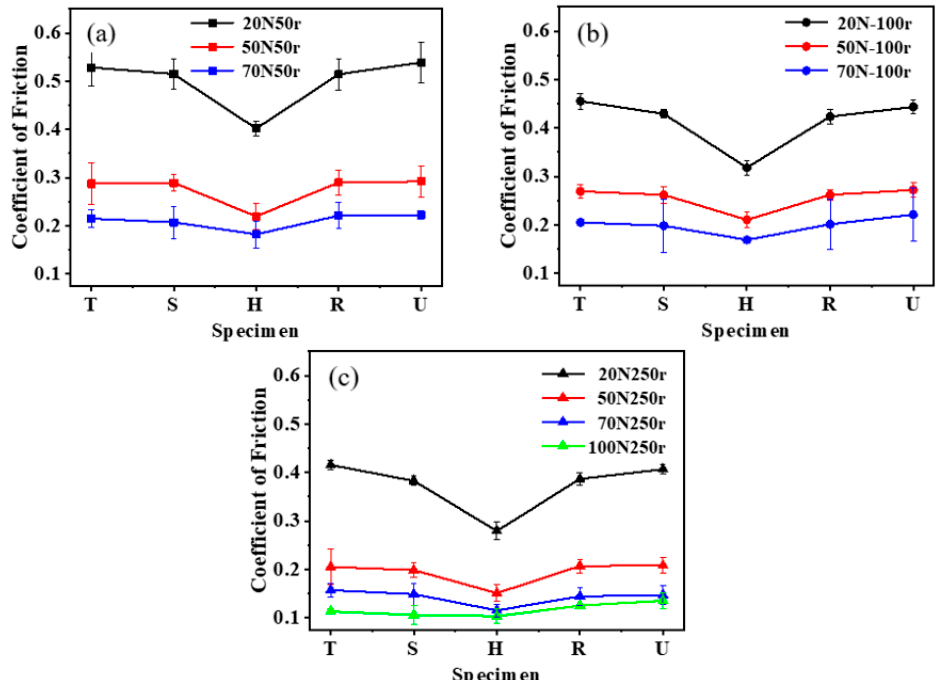
Figure 4. The average friction coefficients of four cross-grooved texture shapes under the rotating speeds of ( a ) 50 r, ( b ) 100 r, and ( c ) 250 r. T (triangular); S (square); H (hexagonal); R (round); and U (untextured).